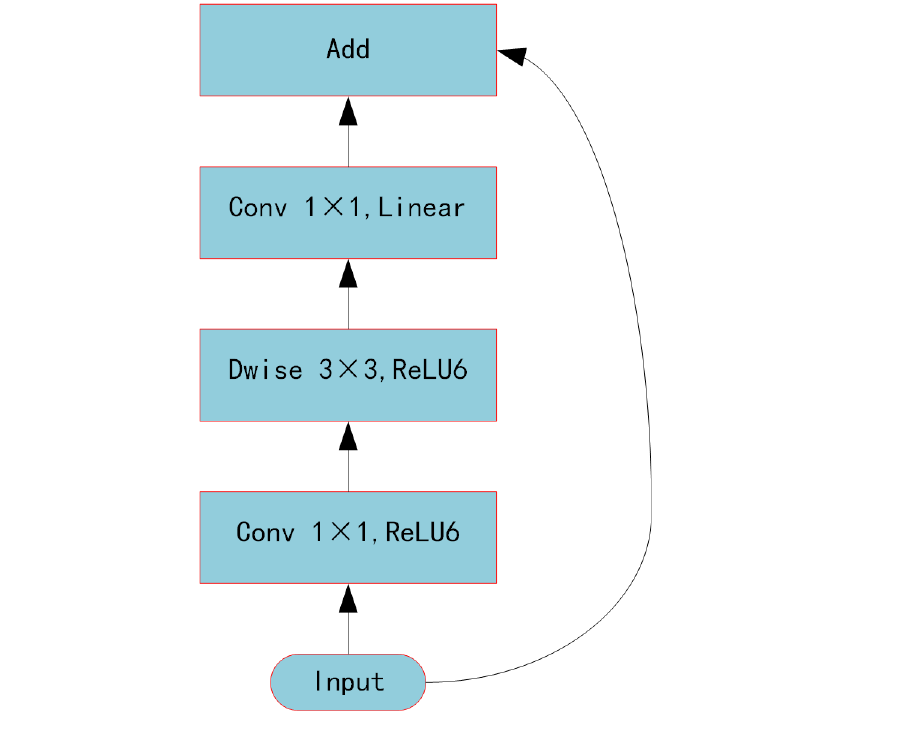
Figure 6. MobilnerV2